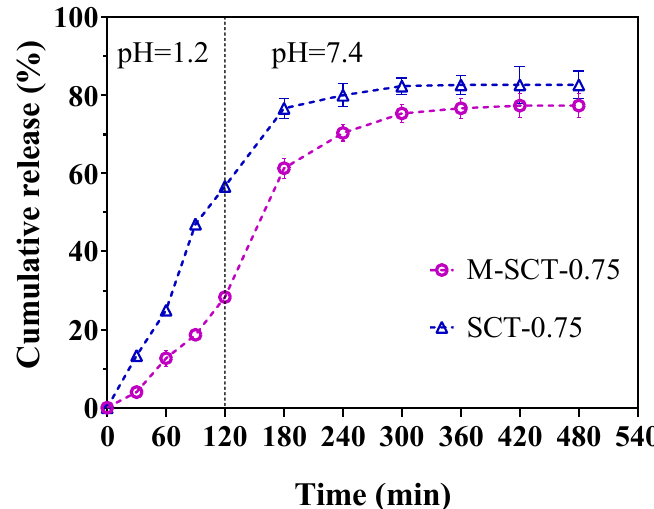
Figure 3. Coating process slows the release of GLP of hydrogels in simulated gastric fluid. GLP release profiles of GLP/SCT-0.75 and GLP/M-SCT-0.75 in simulated gastric and simulated intestinal fl uids determined by Biuret method. The numerical data shown were means ± SE ( n = 3).